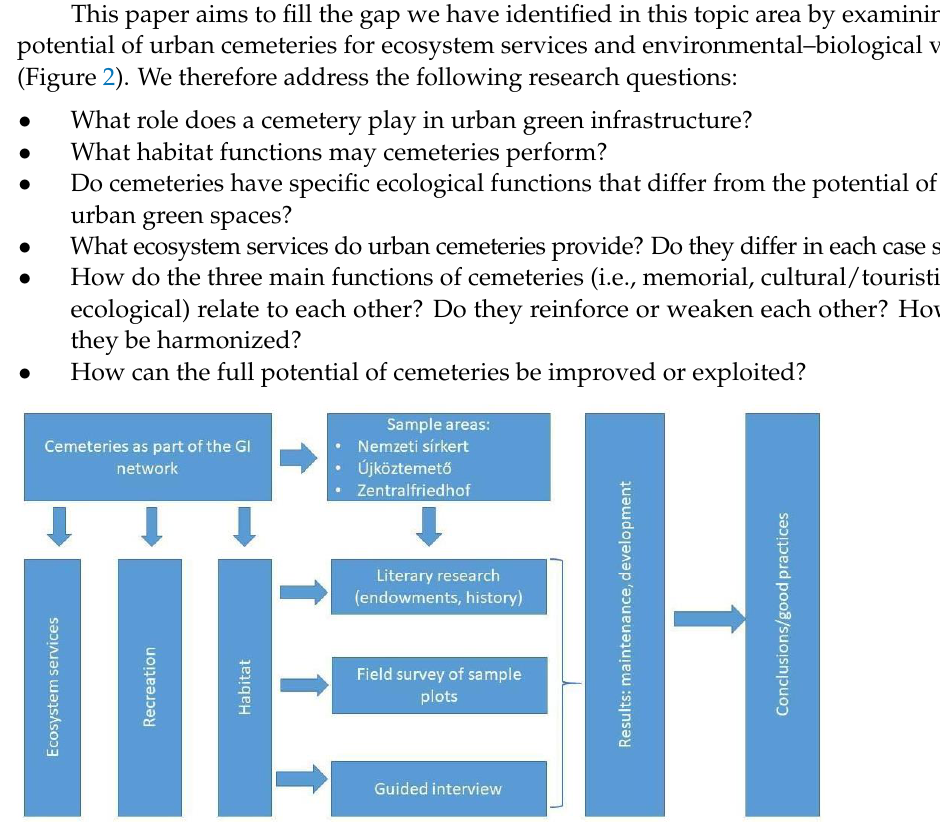
Figure 2. The structure of the study (by